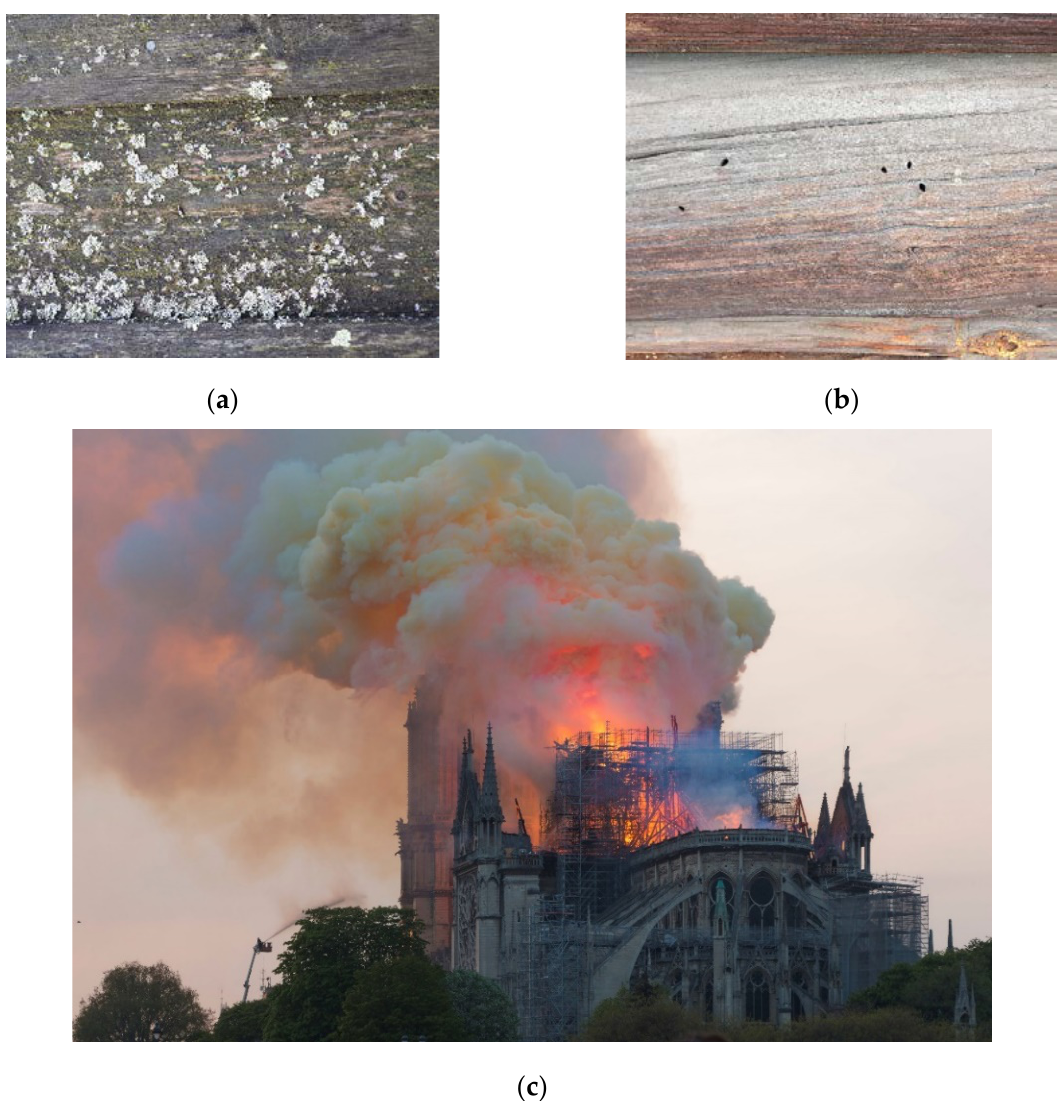
Figure 2. Damage caused by ( a ) Fungi and ( b ) Insect attacks in Heierstad Loft, Tønsberg, Norway; ( c ) Fire in Notre-Dame cathedral timber roof, Paris, France (reprinted from Wikipedia with license CC BY-SA 4.0).